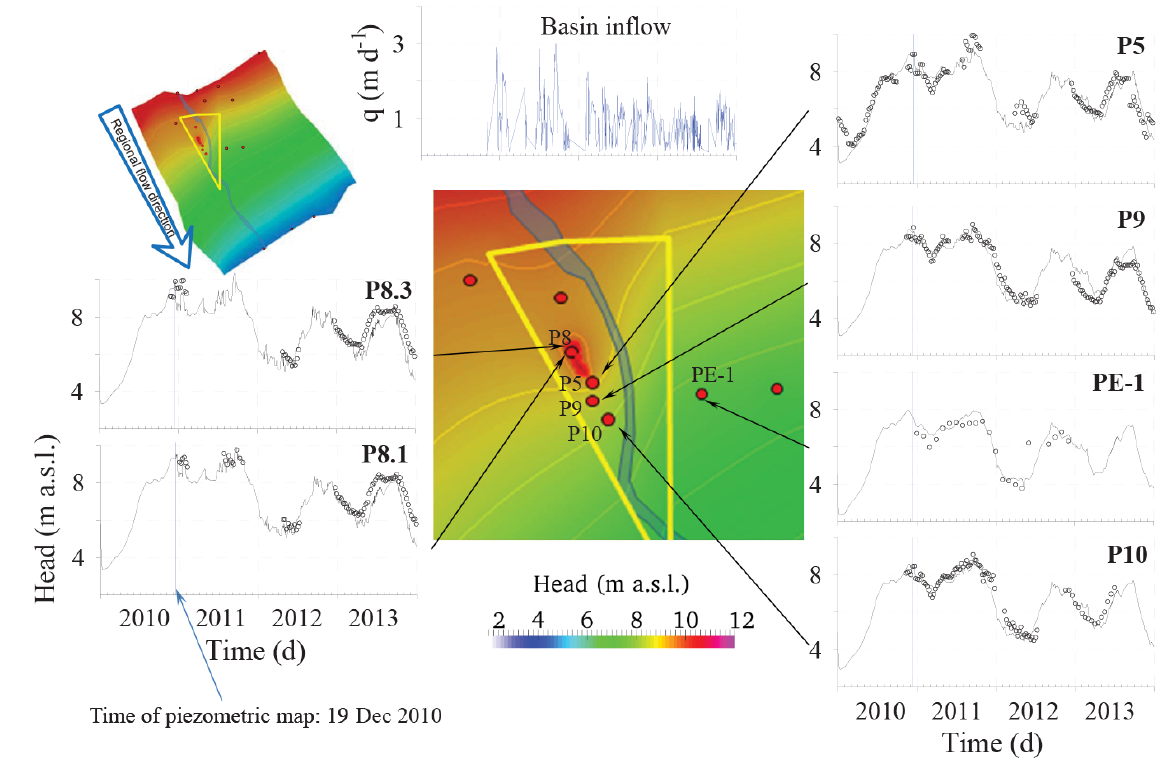
Figure 2. Calculated head level surface on 19 December 2010, when the system was working, and measured (circles) and calculated (line) heads (ma.s.l.) vs. time (m) at five monitoring piezometers (P8.3, P8.1, P5, P9, and P10) and one extraction well